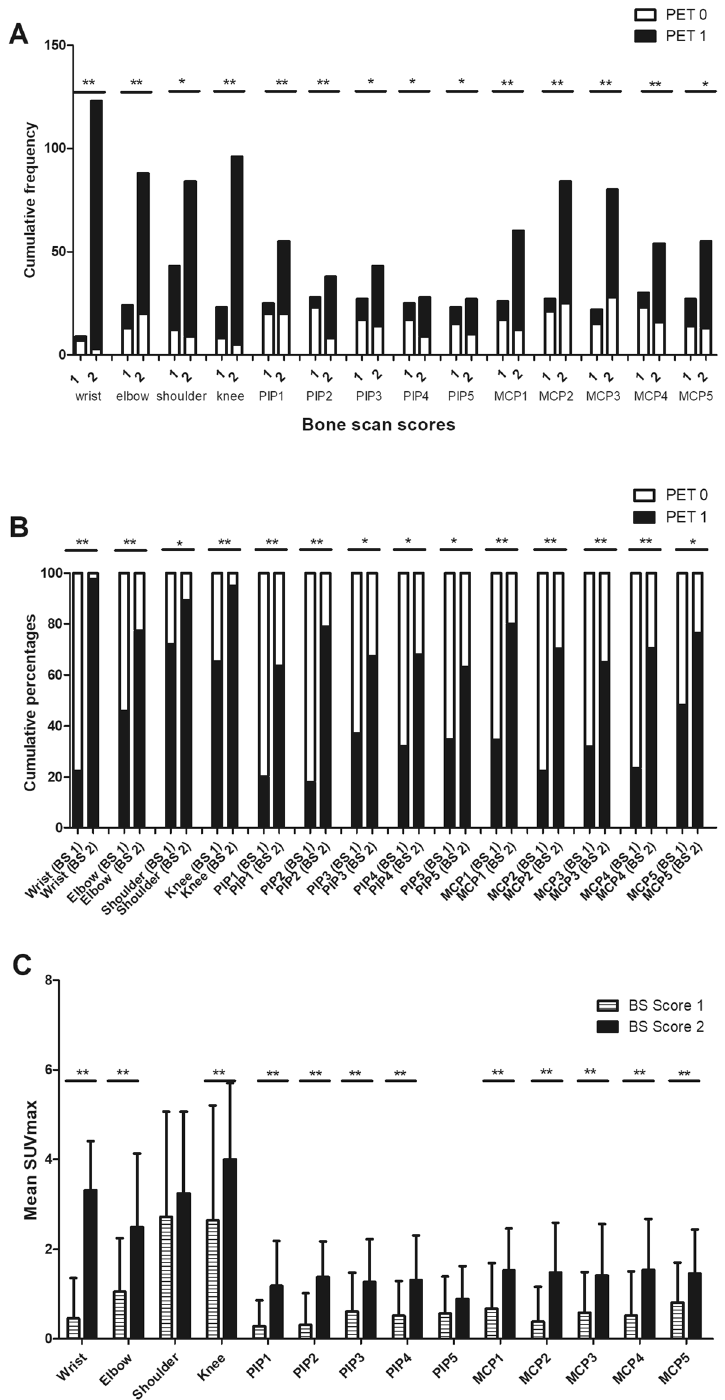
Figure 1. Comparison of positron emission tomography (PET) and bone scintigraphy (BS) in the detection of active joints. The frequencies ( A ), percentages ( B ) and the mean SUVmax ( C ) of PET positive joints were expressed according to BS scores in the affected individual joints among the 67 patients who underwent PET and BS. A total of 134 frequencies were observed for each joint. In total, 12 frequencies in knees were excluded in the analysis because those indicate the status of total knee replacement arthroplasty. When FDG uptake in the joint synovium was higher than normal regional tracer accumulation, the joints were considered positive for active arthritis. PET positive and negative joints were defined as scores 1 and 0, respectively. The 28-joints of each patient in BS were scored as 0–2 (0: negative, 1: weak positive, 2: strong positive). The BS uptake score of 2 was used as a criterion for diagnosing a BS positive joint. MCP, metacarpophalangeal joint; PIP, proximal interphalangeal joint; SUV, standardized uptake values. ** p < 0.005; * p <